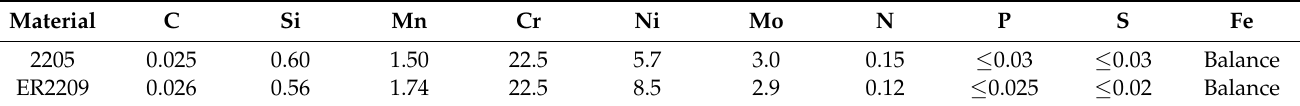
Table 1. Chemical composition of the 2205 duplex stainless steel and solid wire